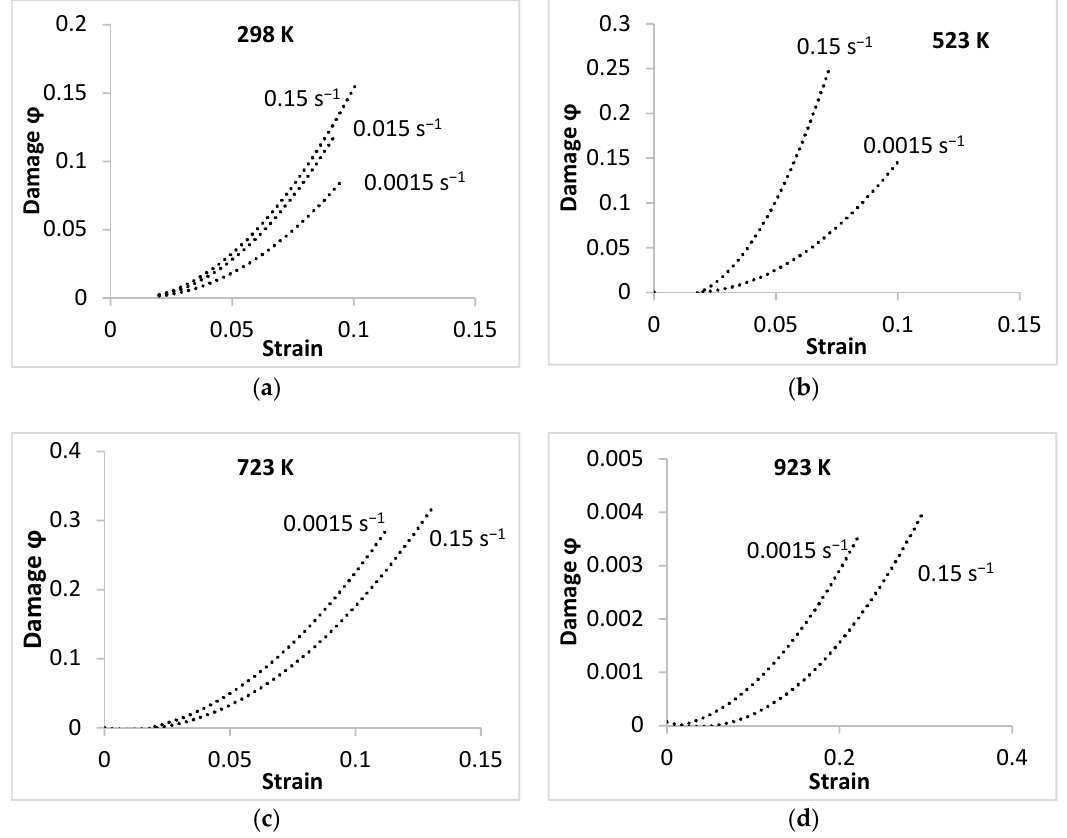
Figure 9. Damage φ evolution at quasi-static strain rates and temperatures of ( a ) 298 K, ( b ) 523 K, ( c ) 723 K and ( d ) 923 K.